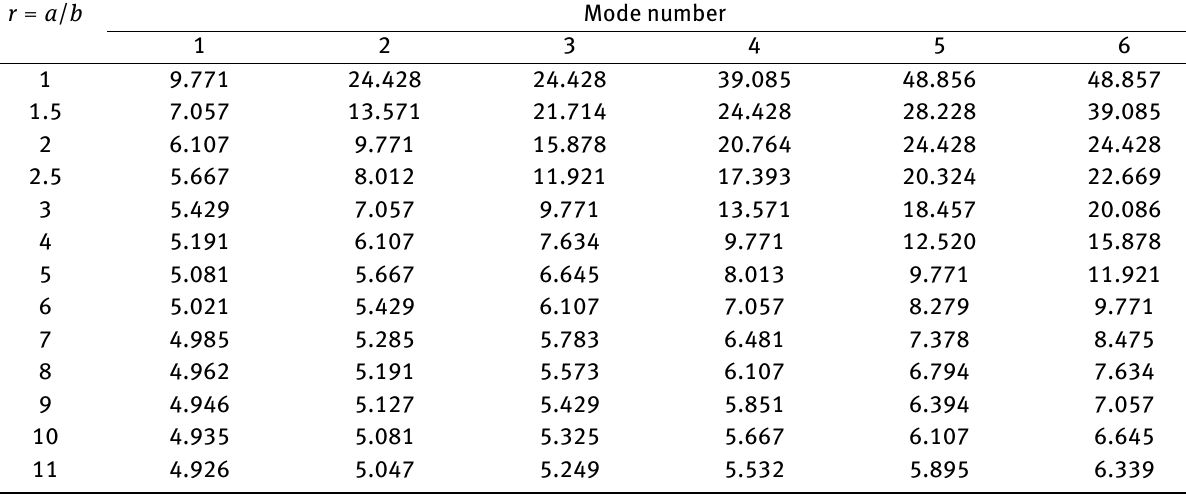
Figure 4: The first six mode shapes of rectangular thin plate with C-C-C-C boundary condition: (a) Current method (b) Abaqus Table 6: The first six natural frequencies for the rectangular thin plate with S-S-S-S boundary condition and different aspect ratios. r = a /